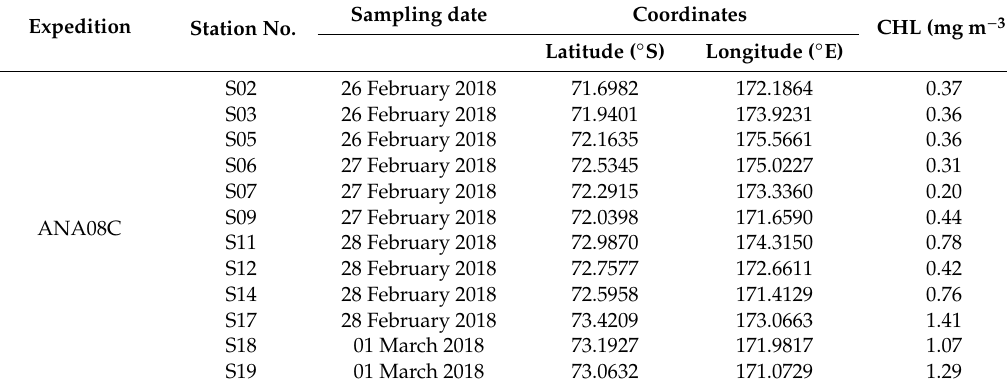
Table 2. Station information for the ANA08C cruises: station number, sampling date, and geographic